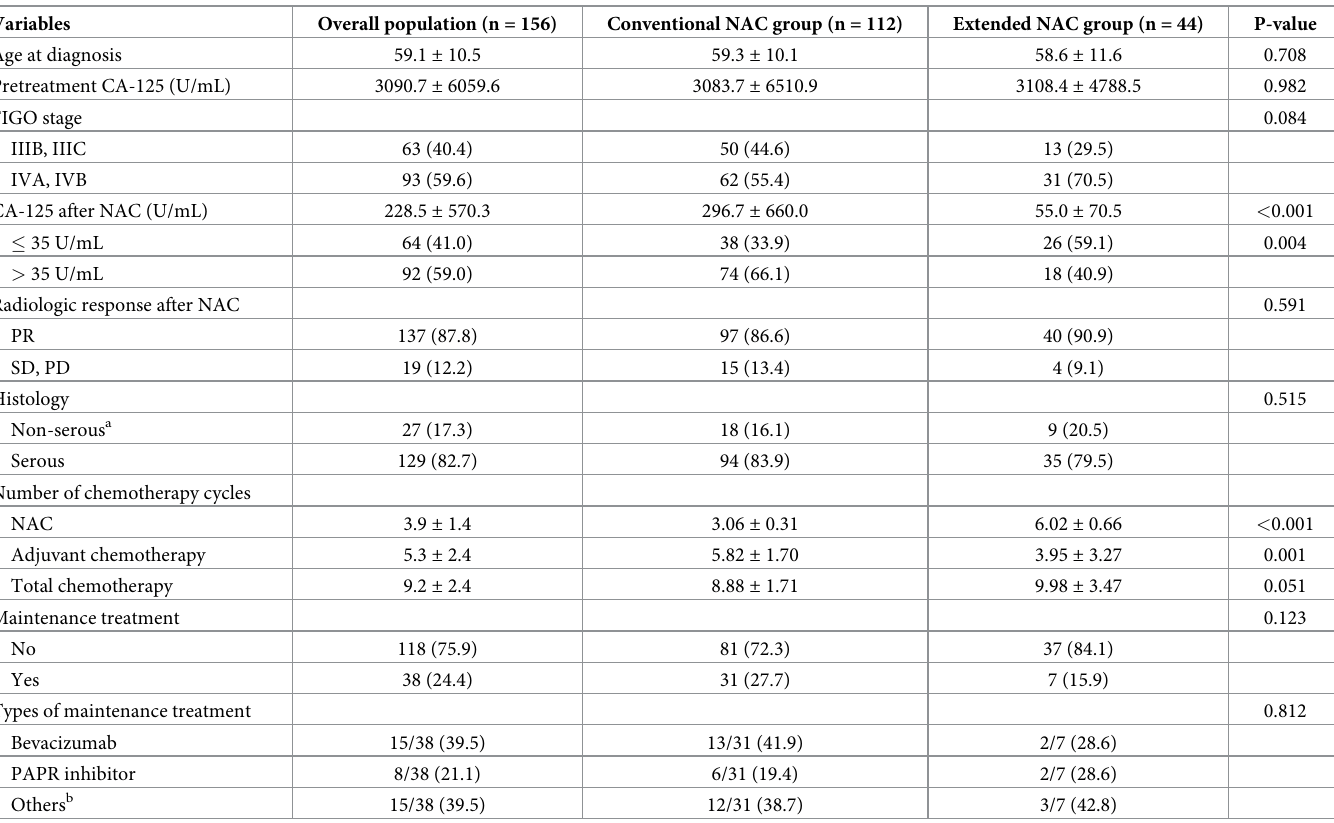
Values are presented as number of patients (%) or mean ± standard deviation. FIGO, International Federation of Gynecology and Obstetrics; NAC, neoadjuvant chemotherapy; PR, Partial Response; SD, Stable Disease; PD, Progressive Disease; PARP, Poly (ADP-ribose) polymerase. a Non-serous histology including four endometrioid, five clear cell, seven mucinous, three carcinosarcoma, eight others. b Others including two monthly paclitaxel, one oral etoposide, and 12 clinical trials (7 ATHENA, 4 MK-7339, 1 DUO-O). 125 level, radiologic response after NAC, histology, and maintenance treatment were similar between the conventional and extended NAC groups. The frequency of FIGO stage IV tended to be higher in the extended as compared to the conventional NAC group, but there was no significant difference (70.5% vs. 55.4%, P = 0.084). This could suggest that the extended NAC group included patients with a higher tumor burden than the conventional NAC group. The mean CA-125 level after NAC was significantly lower in the extended NAC group than that in the conventional NAC group (55.0 U/mL vs. 296.7 U/mL, P < 0.001). Additionally, the rate of CA-125 normalization after NAC was significantly higher in the extended than in the conven- tional NAC group (59.1% vs. 33.9%, P = 0.004). The frequency of receiving two or more cycles of adjuvant chemotherapy was significantly higher in the conventional than in the extended NAC group (99.1% vs. 84.1%, p = 0.001). The total number of chemotherapies, including NAC and adjuvant chemotherapy, showed no significant difference between the two groups (con- ventional vs. extended NAC group; mean ± standard deviation; 8.88 ± 1.71 vs. 9.98 ± 3.47,